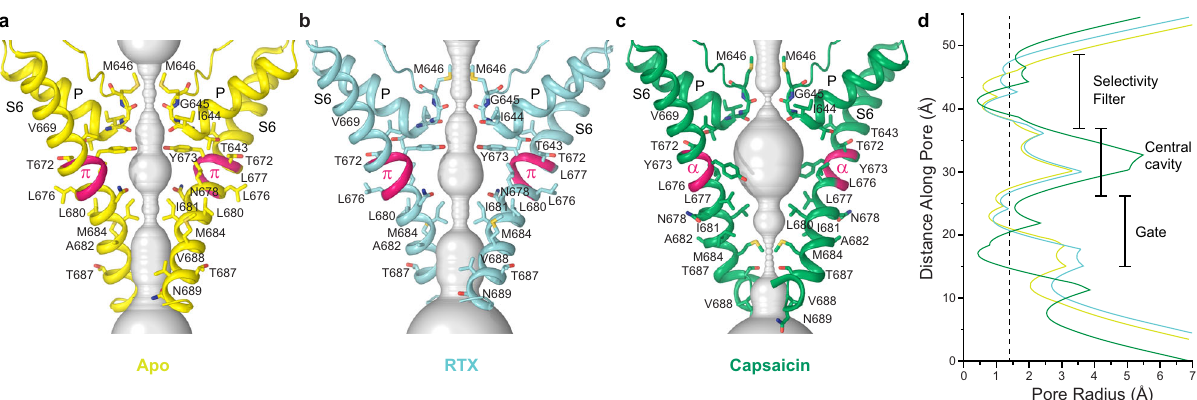
Fig. 4 Ion channel pore. a – c Pore-forming domains in the apo ( a ), RTX-bound ( b ) and capsaicin-bound ( c ) states with the residues lining the pore shown as sticks. Only two of four subunits are shown, with the front and back subunits omitted for clarity. The pore pro fi les are shown as space- fi lling models (gray). The region that undergoes α -to- π transition in S6 is highlighted in pink. d The pore radius for the sqTRPV1 structures calculated using HOLE 47 . The vertical dashed line denotes the radius of a water molecule, 1.4